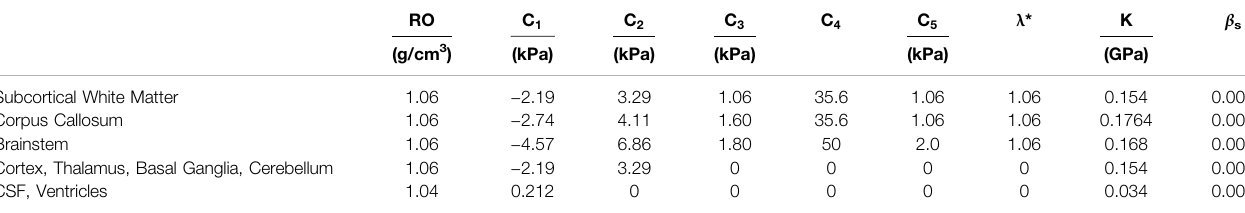
TABLE 1 | Optimized brain material properties de fi ned for the GHBMC v.6.0 brain